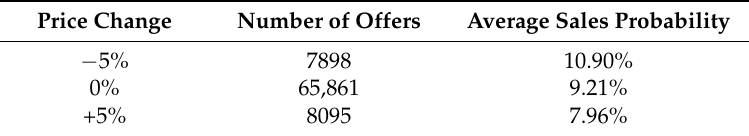
Table 1. Summary of the results from the price test